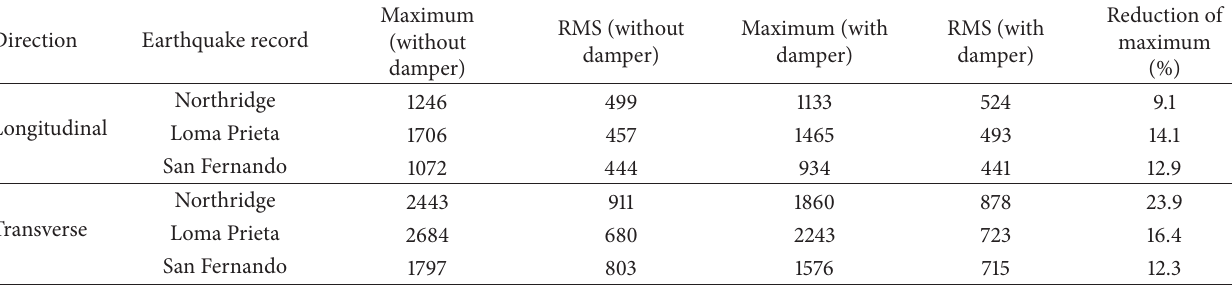
Table 5: Maximum and RMS values of the base shear of the concrete pier (kN).